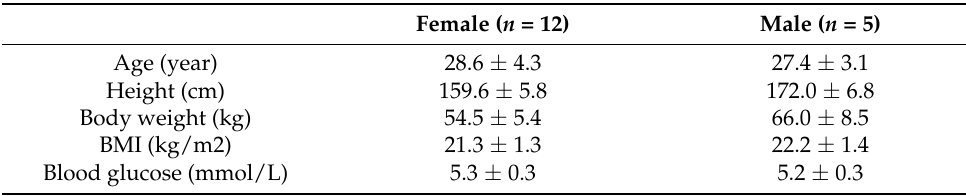
Figure 4. Flow diagram of subjects throughout the study. Tests days were five non-consecutive days with ≥ 72 h intervals. Final data collected for each food: CG ( n = 17), P-SG ( n = 17), T-SG ( n = 17), Glucose ( n = 34). Table 4. The body index of subjects during experiment (Mean ± SD).